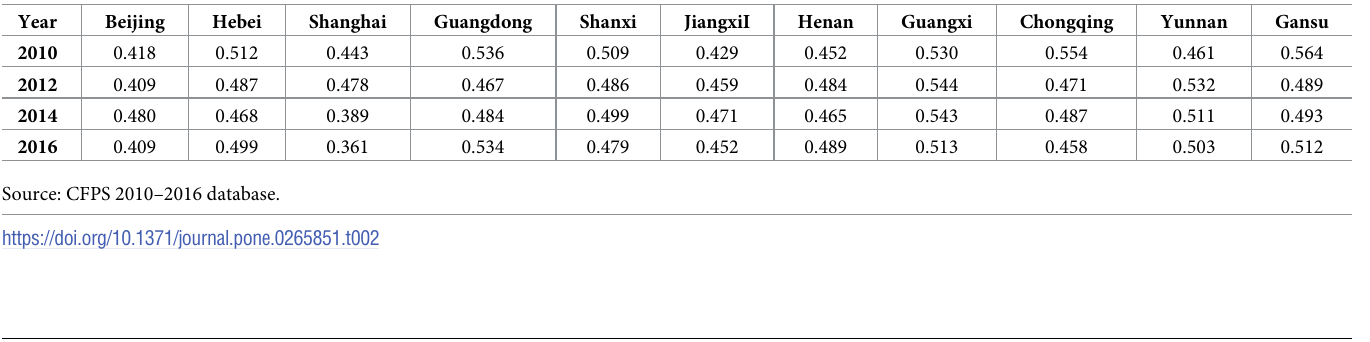
Table 2. Gini coefficients for selected